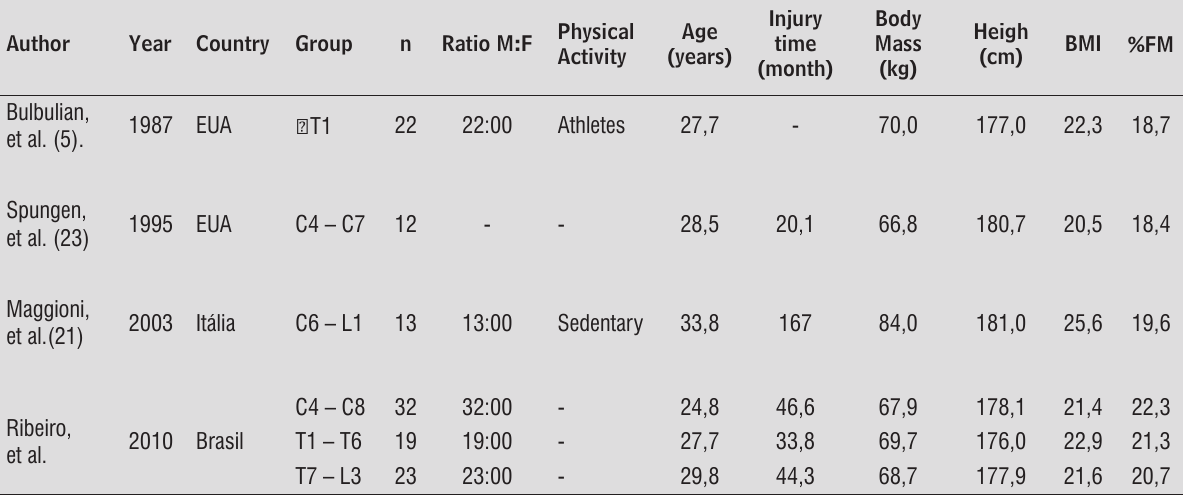
Table 3 – Values of fat mass percentage of Durnin and Womersley (1962) and anthropometric variables in several studies in individuals with spinal cord injury